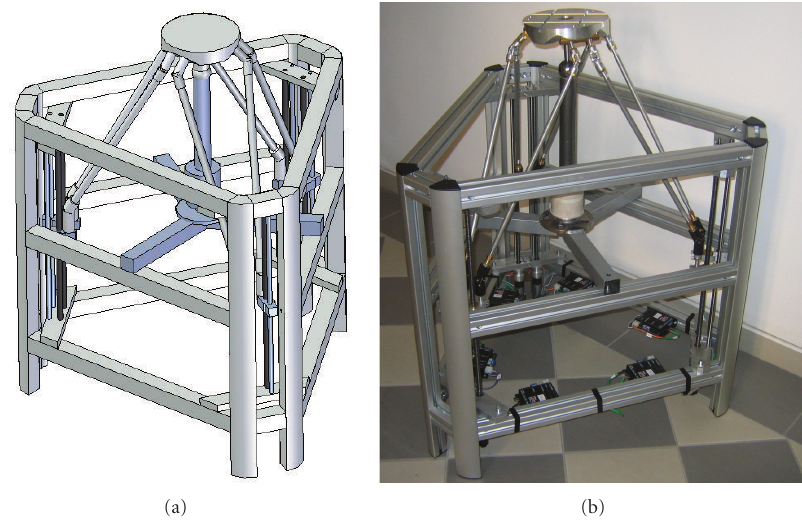
Figure 10: Engineering design and functional model of Hexasphere.